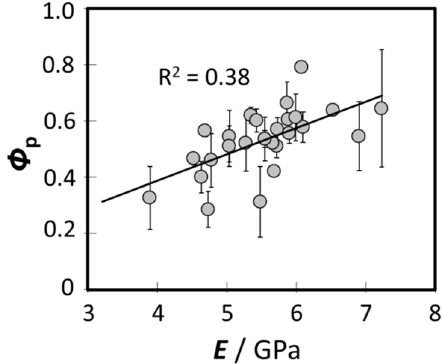
Figure 3. Fraction of the para-like cortex to the whole cortex ( Φ p ) vs. macroscopic bending modulus E . Circles with an error bar, mean ± standard deviation (SD) of each subject; Solid line, result of linearization. The coefficient of determination R 2 is 0.38.